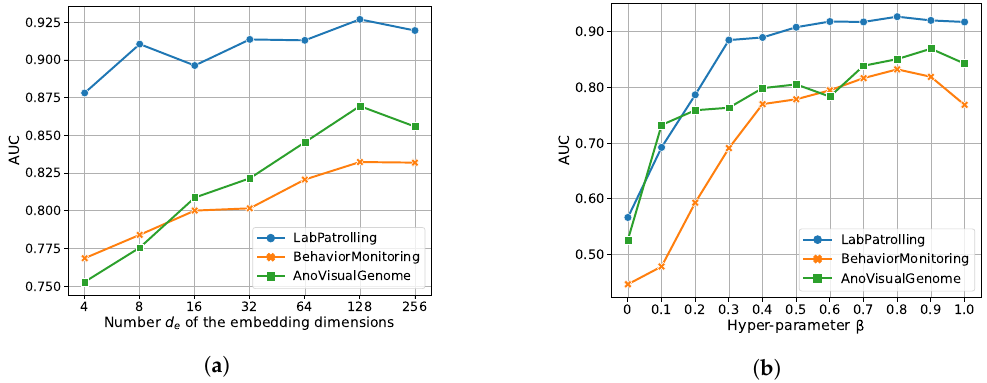
Figure 9. Parameter sensitivity study of SSGAE. ( a ) Number d e of the embedding dimensions versus AUC. ( b ) Hyper-parameter β in the objective function versus